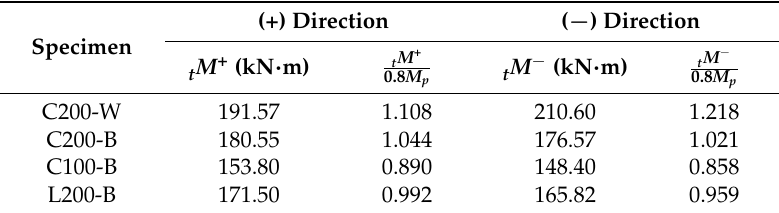
Table 11. Comparison of a moment for a special moment frame.